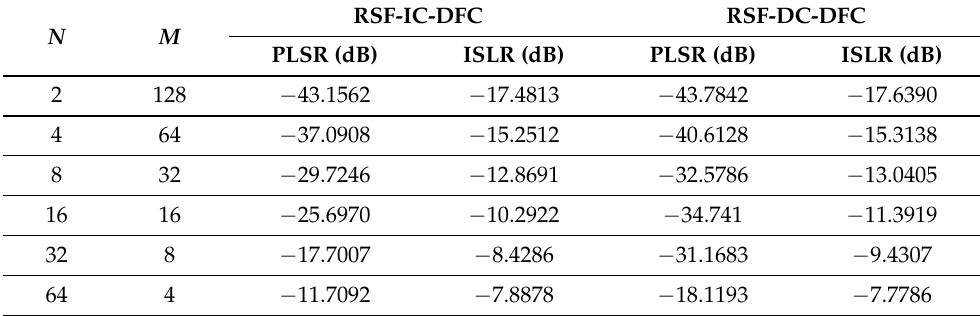
Table 3. Comparison of the image sidelobe performance with different N and M